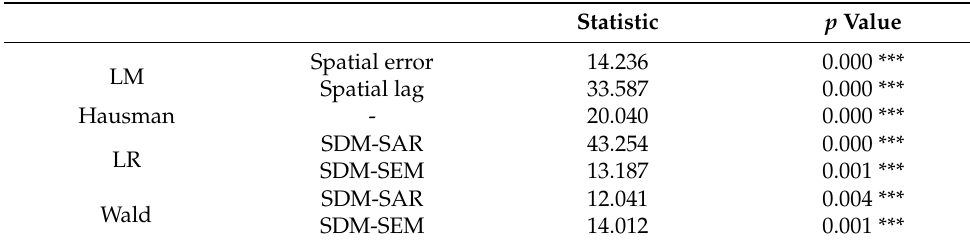
Table 7. Statistical tests of the spatial econometric